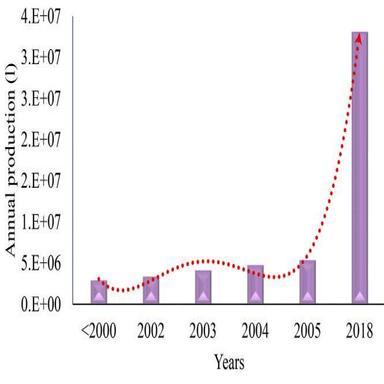
The radically increasing trend in the potable alcohol production in Ethiopia.